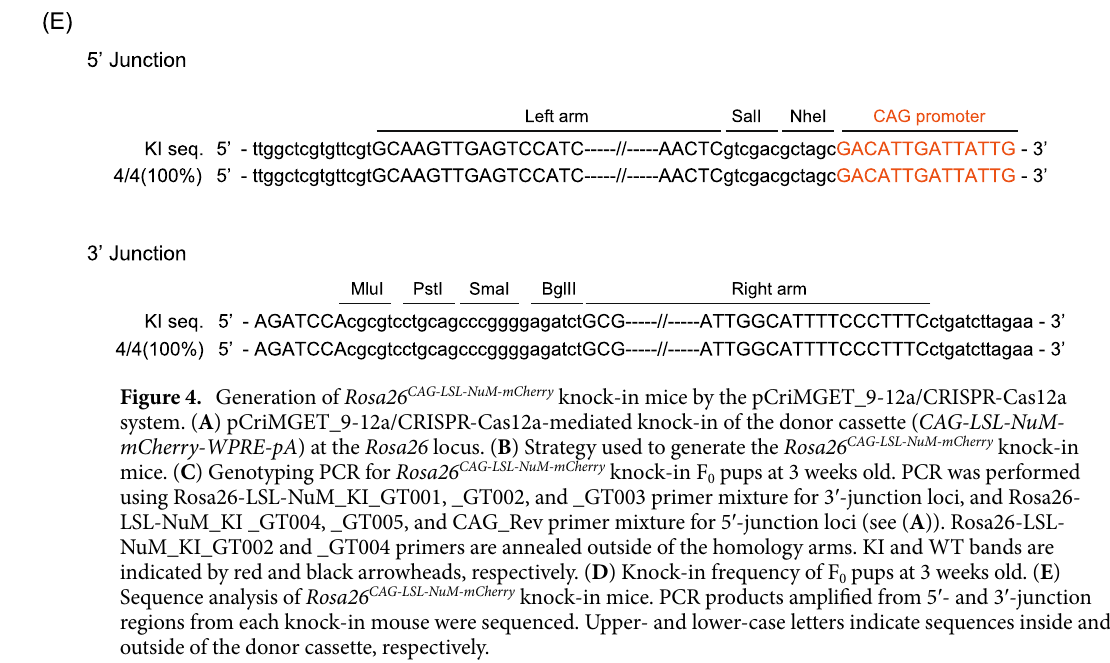
regions from each knock-in mouse were sequenced. Upper- and lower-case letters indicate sequences inside and outside of the donor cassette,